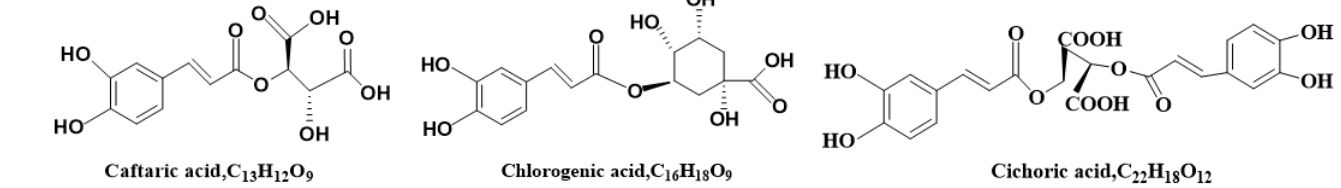
Figure 1. Chemical structure of representative components in Echinacea purpurea (L.) Moench.